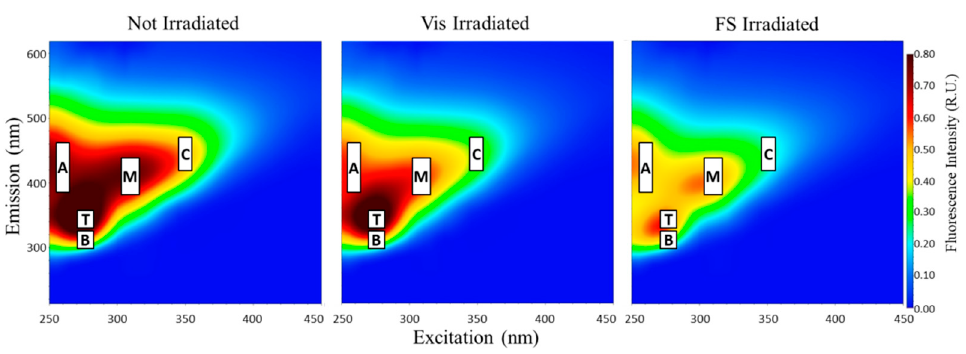
Figure 5. Examples of Excitation-Emission matrixes (EEMs) of CDOM released by E. huxleyi measured before and after irradiation with Vis and FS. The typical CDOM fluorophores are shown on the EEMs.